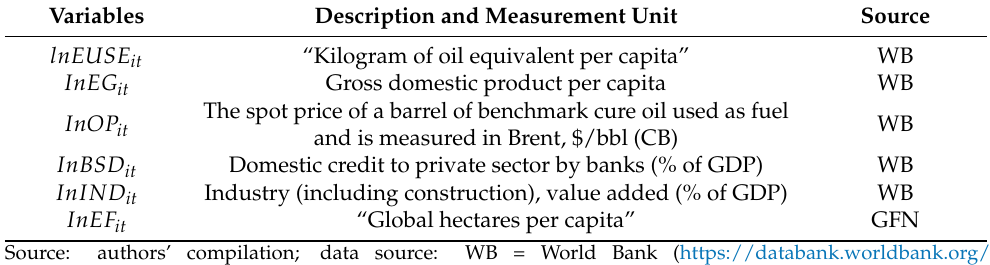
Table 1. Variables description and sources of